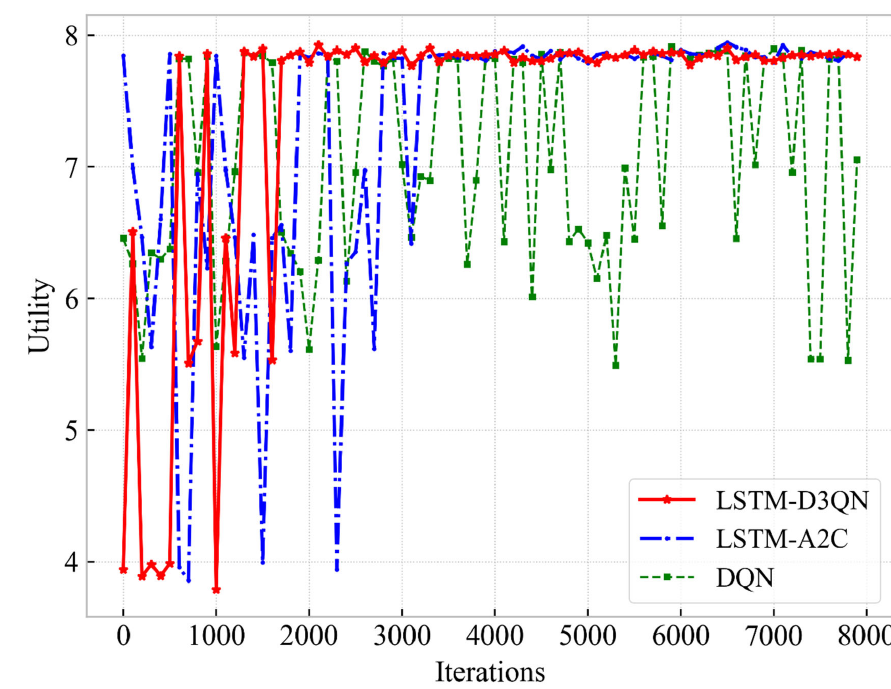
Figure 3. The comparison of system utility for different methods.